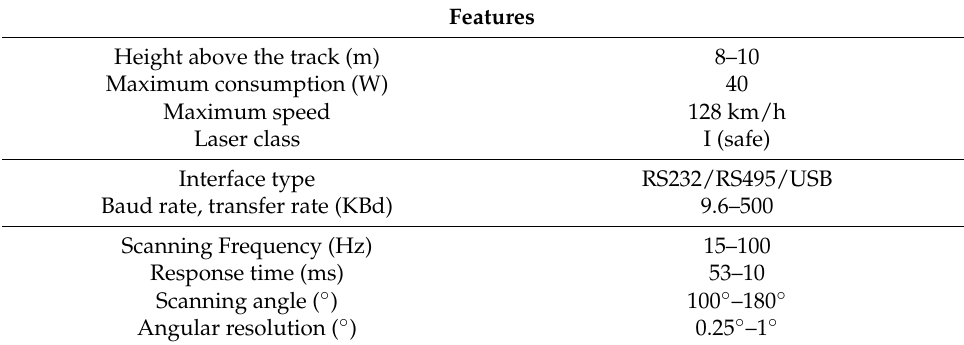
Table 3. Specifications achieved.